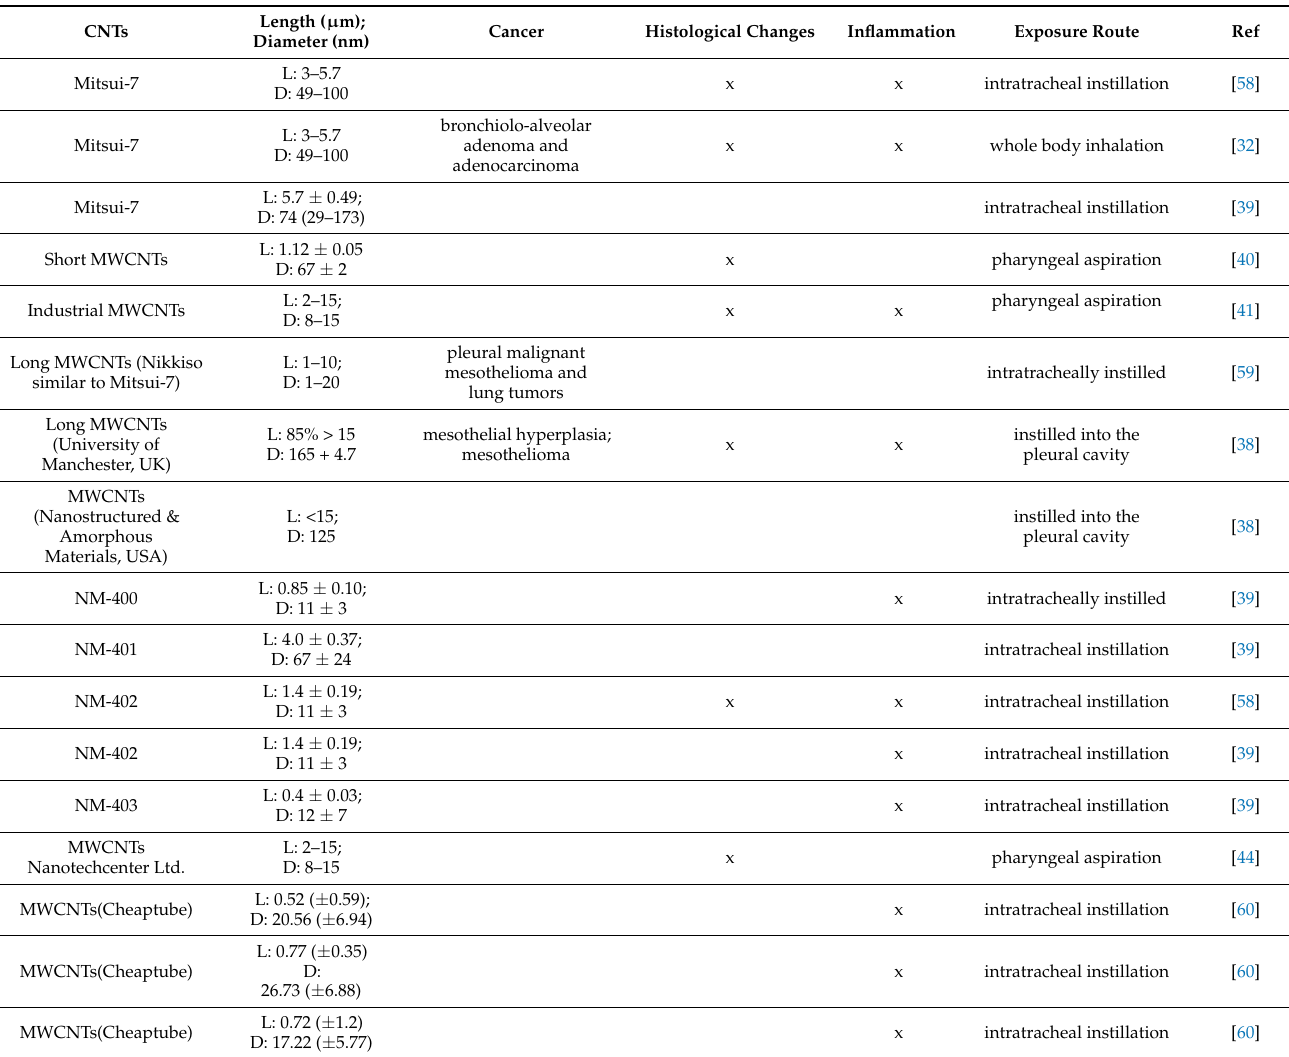
Table 1. Cancer development, histological changes, and inflammatory response observed in in vivo experiments with